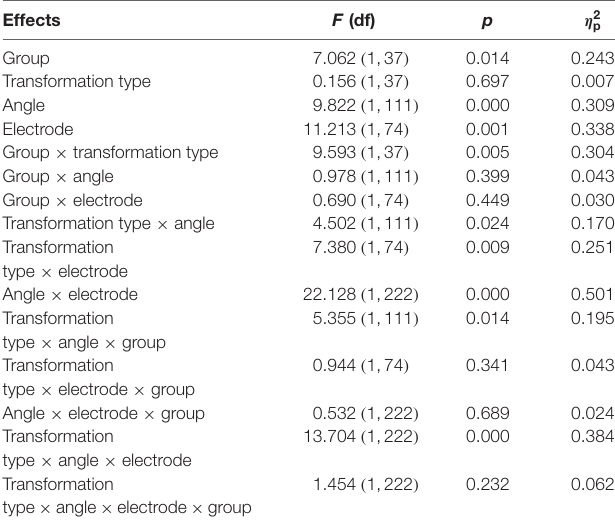
TABLE 2 | ANOVA results of average amplitude of rotation-related negativity